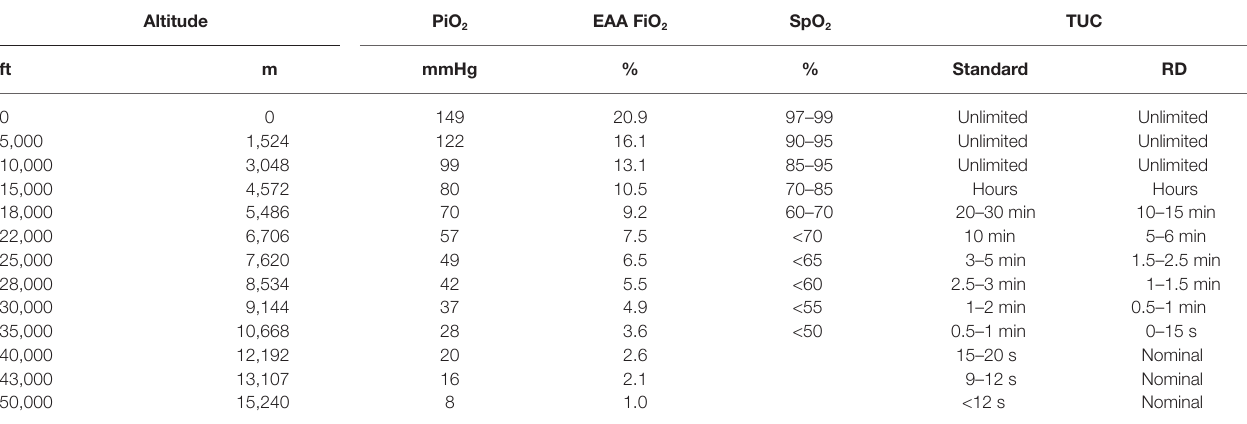
TABLE 2 | Estimated TUC with increasing hypoxia